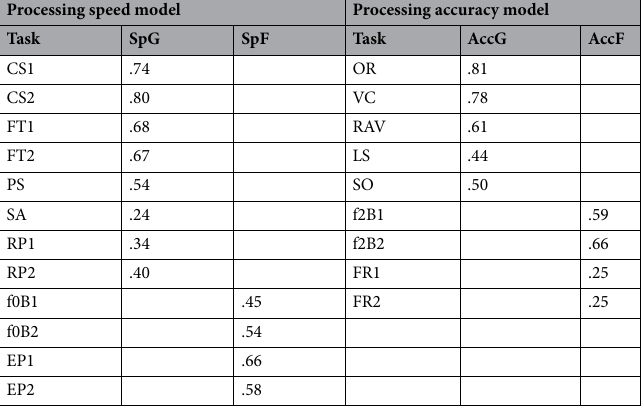
Table 1. Standardized factor loadings estimated in the brain-behavior models . All factor loadings are statistically significant ( p < .05). SpG speed of general cognition, SpF speed of face processing, AccG accuracy of general cognition, AccF accuracy of face processing, CS1 dimensional change card sort task, color domain, CS2 dimensional change card sort task, shape domain, FT1 flanker inhibitory control and attention task, congruent condition, FT2 flanker inhibitory control and attention task, incongruent condition, PS pattern comparison processing speed, SA sustained attention, RP1 relational processing, first scan as indicator 1, RP2 relational processing, second scan as indicator 2, f0B1 facial working memory 0-back, first scan as indicator 1, f0B2 facial working memory 0-back, second scan as indicator 2, EP1 facial emotion processing, first scan as indicator 1, EP2 facial emotion processing, second scan as indicator 2, OR oral reading recognition test, VC vocabulary comprehension, RAV Raven progressive matrices, LS list sorting working memory, SO spatial orientation, f2B1 facial working memory 2-back task, first scan as indicator 1, f2B2 facial working memory 2-back task, second scan as indicator 2, FR1 face recognition, first scan as indicator 1, FR2 face recognition, second scan